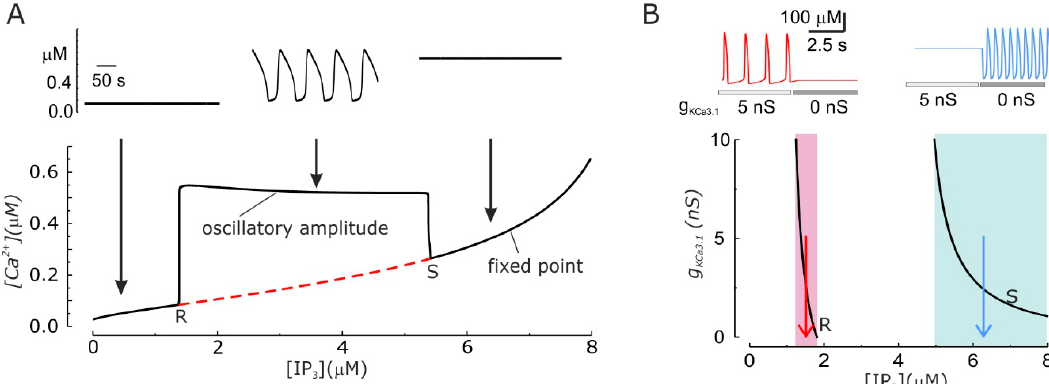
Figure 3. Ca 2+ oscillation development depends on the IP 3 concentration and the activity of KCa3.1 channels. ( A ) Bottom. Bifurcation diagram showing that IP 3 concentration determines the establishment of the Ca 2+ oscillations. The red dashed line represents the unstable equilibrium [Ca 2+ ] i . The computation was performed with g KCa3.1 = 5 nS. R and S indicate the Hopf bifurcations where Ca 2+ oscillations appear and disappear, respectively, upon increasing the IP 3 levels. Top. The traces show the temporal changes of the [Ca 2+ ] i for three different concentrations of IP 3 (indicated by arrows in the bottom part). ( B ) Bottom. Plot of the two Hopf bifurcations (R and S) as a function of the IP 3 concentration and g KCa3.1 . Three different ranges of IP 3 concentrations, where the KCa3.1-induced V m oscillations appear to have different effects in the modulation of Ca 2+ oscillations are evidenced (shaded areas; see text). More specifically in the pink region the presence of KCa3.1 channels is necessary for the existence of Ca 2+ oscillations, in the light blue region KCa3.1 channels prevents Ca 2+ oscillations, and finally in the white region in between KCa3.1 channels modulate the shape and duration of oscillation. Top. Simulated Ca 2+ oscillations obtained with two IP 3 concentrations (1.5 left and 6.2 µ M right, as indicated by the red and blue arrows below) within the regions where removing KCa3.1 channels make Ca 2+ oscillations disappear or appear. (Modified from [48].)